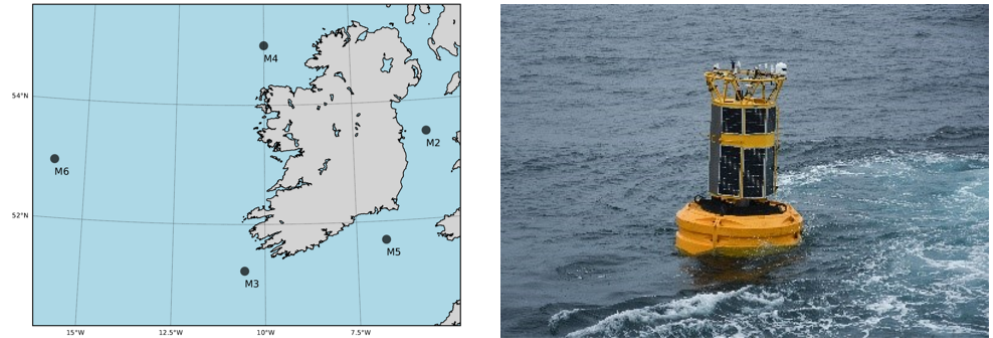
Figure 1. Left : Map indicating current IMDBON buoy locations around Ireland. M6, the main subject of this paper, is located at 52.986 N–15.866 W; Right : A 3rd generation IMDBON buoy—the full height of the buoy is over 6 m, and the platform weighs more than five